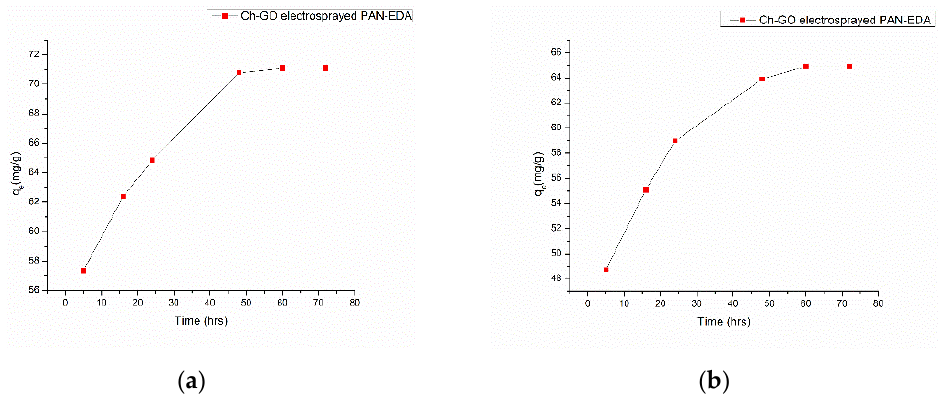
Figure 10. The absorption capacity for ( a ) MB and ( b ) CR as a function of contact time at tempera- ture = 300 K, pH = 7, and adsorbent dosage = 5 mg.